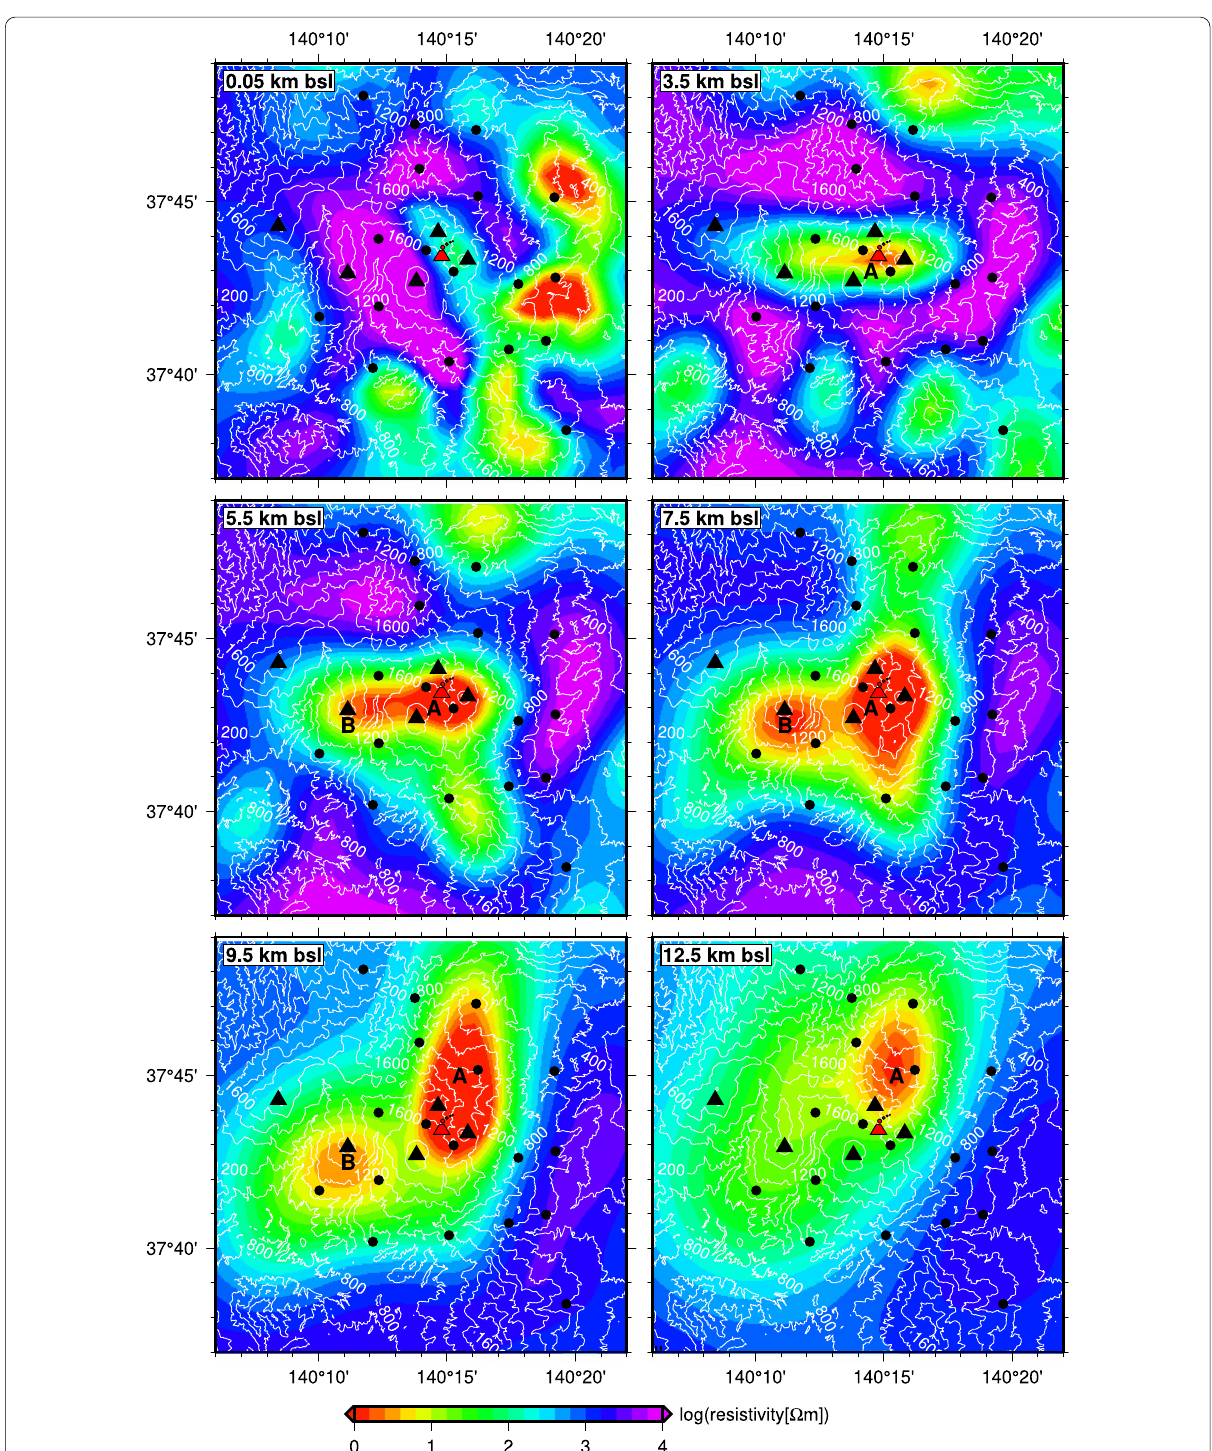
Fig. 5 Plan or map view of the final resistivity model at a depth of 0.05, 3.5, 5.5, 7.5, 9.5, 12.5 km bsl. The background color represents the logarithmic resistivity value. The black circles, white lines, red character, and black triangles, are observation sites, topographic contours, Oana Crater, and edifice summits, respectively (see Fig. 1). The A and B for the conductors are referred to in the